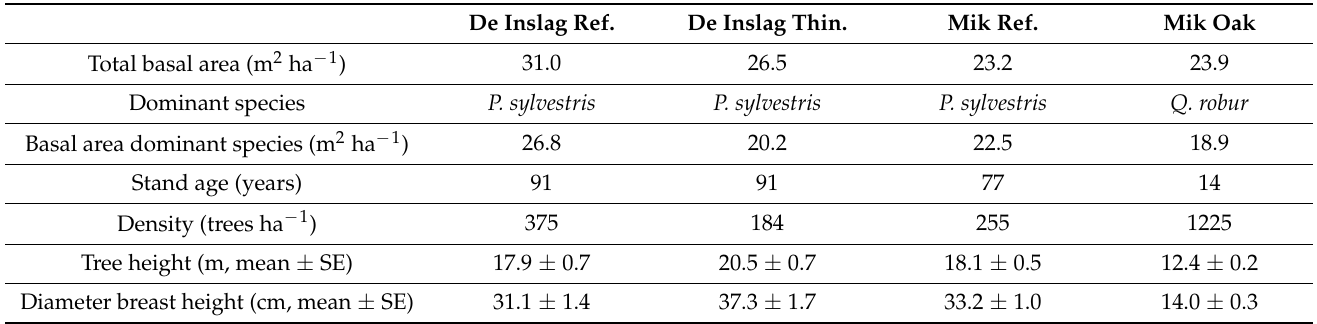
Table 1. Stand characteristics in winter